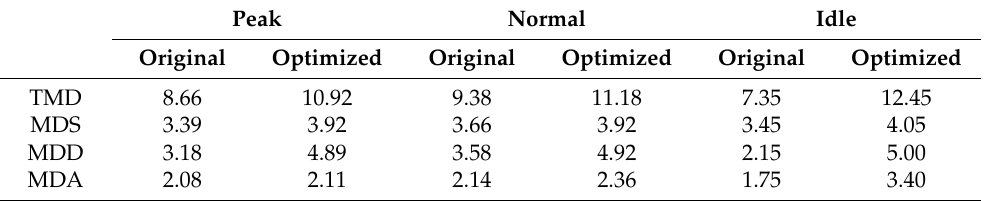
Table 5. Average indicators under three scenarios before and after optimization.